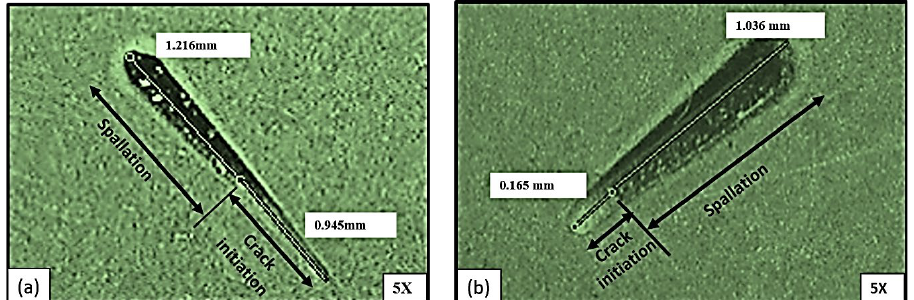
Figure 7. Scratch mark observed during the adhesion test at 5X on ( a ) electrodeposited aluminized steel, ( b ) without electrodeposition aluminized steel.